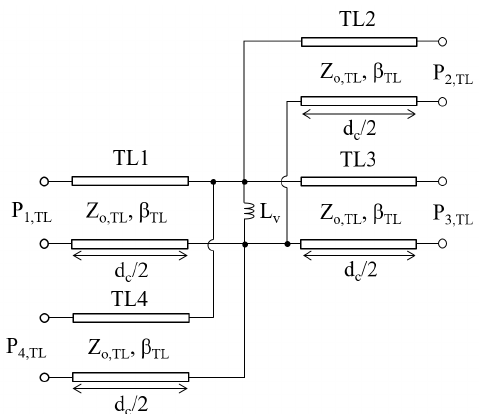
Figure 4. An equivalent circuit model of a 2-D transmission line supporting the quasi-transverse electromagnetic (TEM) mode for analytical UC modeling.